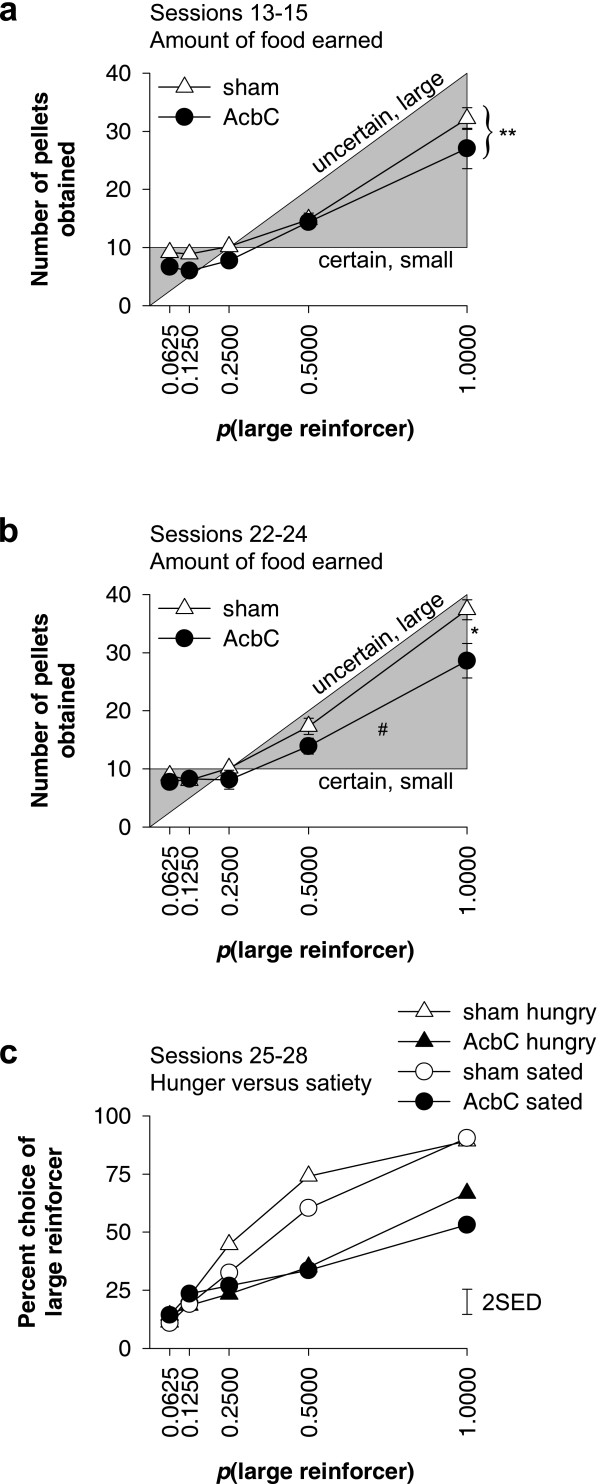
Amount of food obtained, and effects of satiety on choice. (a) Number of pellets obtained in each trial block; average of the first three postoperative sessions, 13–15 (** p < .01, main effect of lesion). The grey area indicates the expected range of options available to a rat making no omissions: consistent responding on the lever delivering the small, certain reward of a single pellet yields 10 pellets per trial block (horizontal border of the grey area); consistent responding on the lever delivering the large, uncertain reward yields an expected number of pellets that varies with the probability in force (as shown by the diagonal border of the grey area). Optimal behaviour, to maximize the expected amount of food, is to choose the small/certain lever when the large (4-pellet) reinforcer probability is less than 0.25 and to choose the large/uncertain lever when this probability exceeds 0.25. (b) As for (a), but showing data from the final baseline postoperative sessions, 22–24 (# p < .05, lesion × probability interaction; * p < .05, simple effect of lesion). (c) Effects on choice of alternating subjects between states of hunger and satiety. The error bar is twice the SED for the three-way (lesion × hunger × probability) interaction.